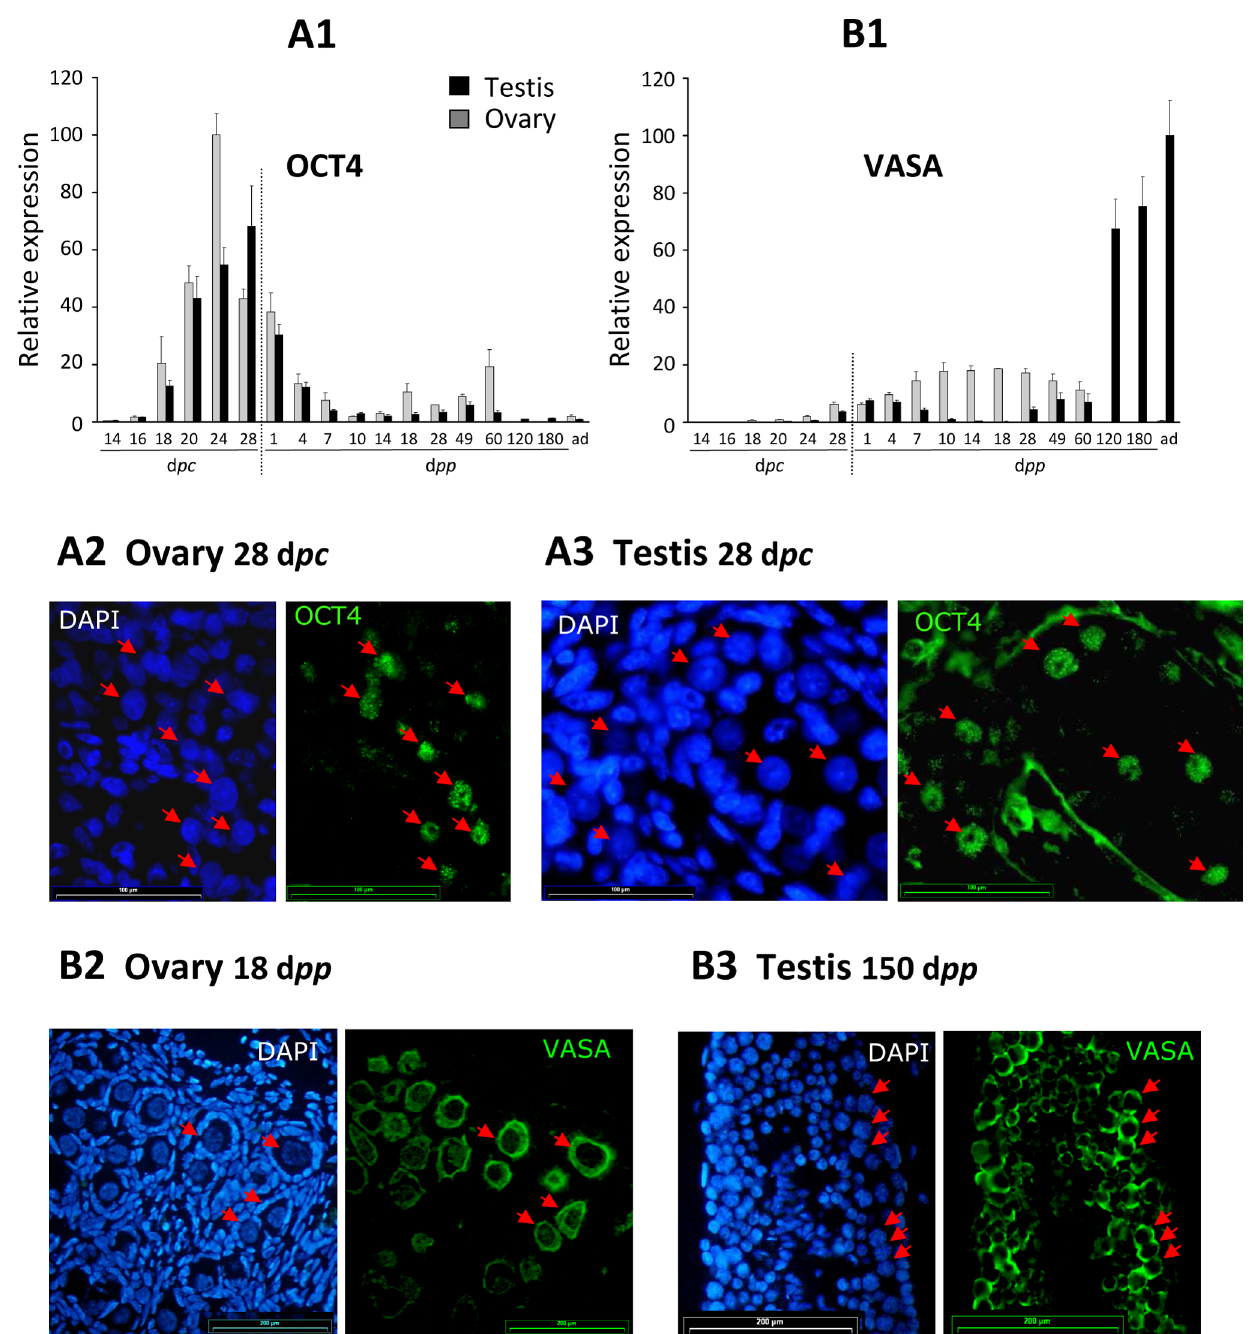
proteins in paraffin sections of gonads. Immunofluorescence pictures are given with each DAPI counterstaining. The antibody against OCT4 stains the nuclei of germ cells in 28 d pc testis (A2) or ovary (A3). Using the antibody against VASA, a cytoplasmic fluorescence is visible in germ cells in 18 d pp ovaries (B2) and 150 d pp testes. Red arrows point to the specifically labelled nuclei. Horizontal bars represent 100 m m (A2 and A3) or 200 m m (B2 and